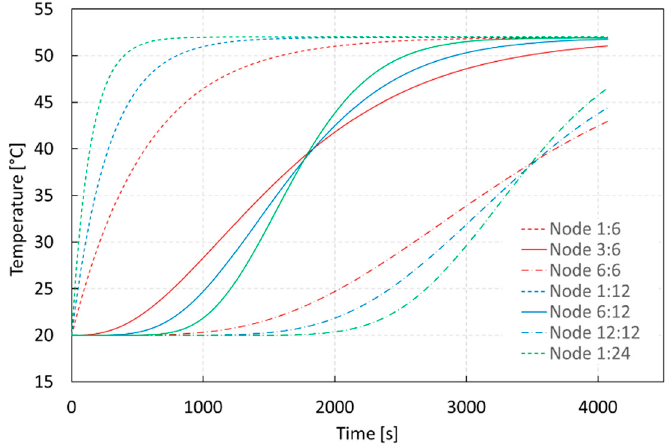
Figure 9. Temperature evolution during the charge phase from models with a different number of nodes.